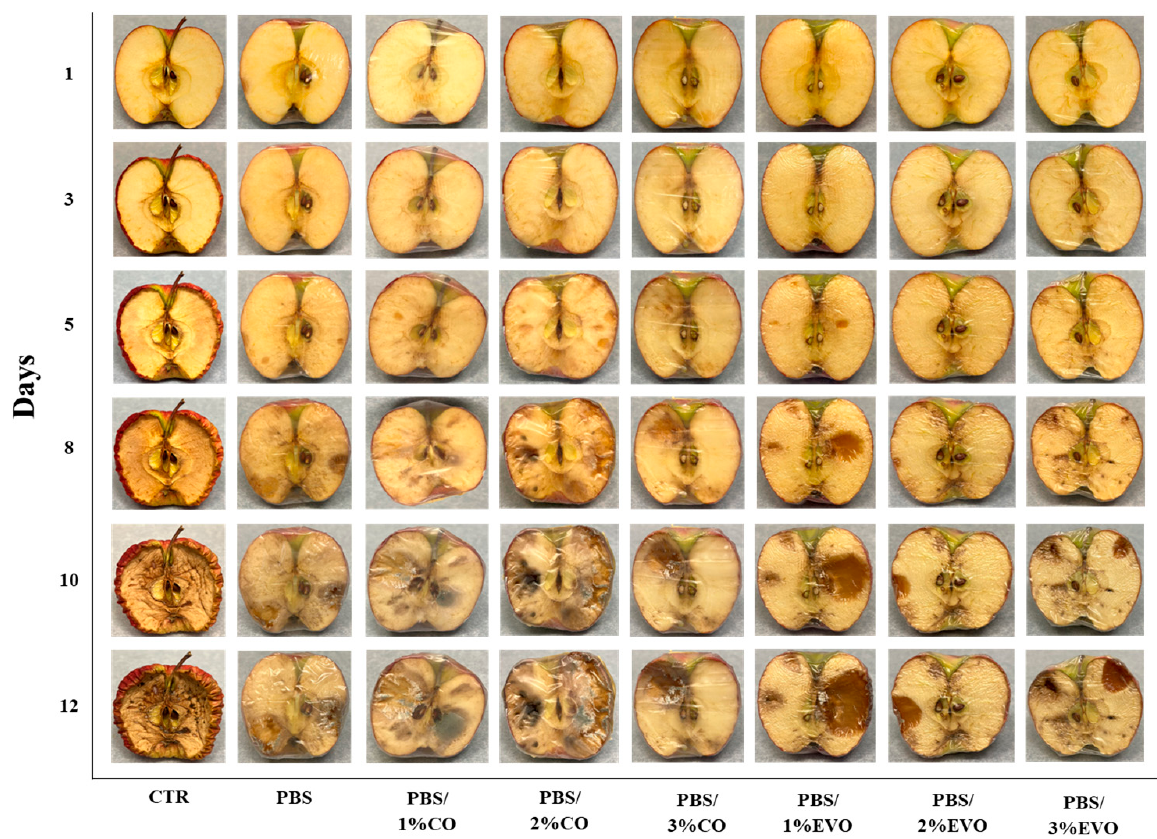
Figure 9. Appearance of fungal growth on sliced kiwi after 12 days of storage with and without PBS and PBS-based films/formulations stored at room temperature.